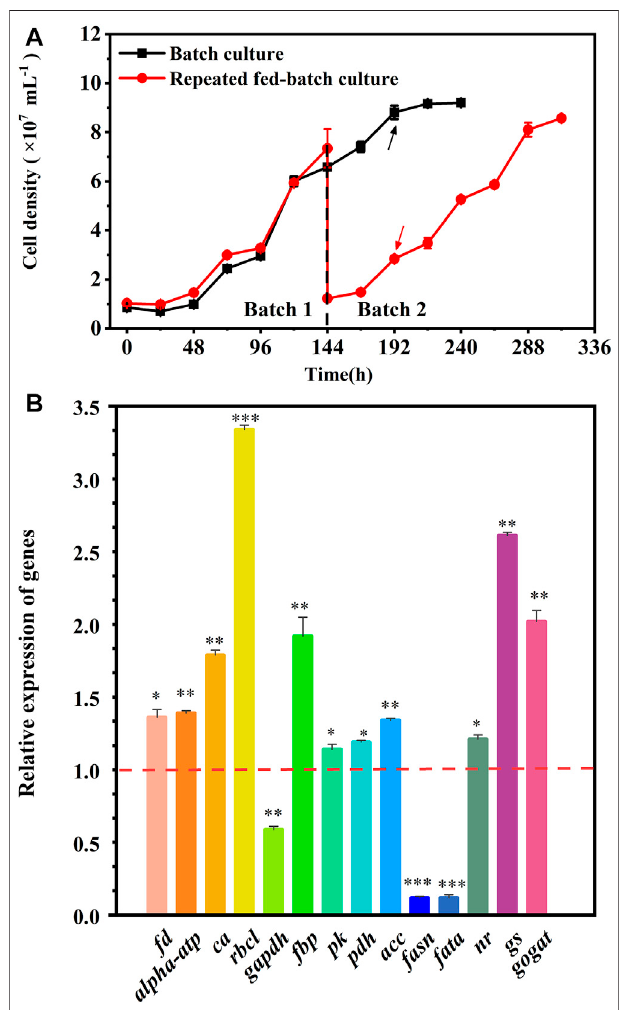
FIGURE 4 | Cell growth (A) and the relative expression of key genes (B) in the batch and repeated fed-batch cultures in 5-L photo-fermenters. The expression levels of key genes encoding key enzymes in the batch culture at 192 h are set to 1.0 as the control. The value > 1.0 means the upregulation of key genes, while the value < 1.0 means the downregulation of key genes. Signi fi cant difference is presented at * p < 0.05, ** p < 0.01, and *** p < 0.001 when compared with the control,